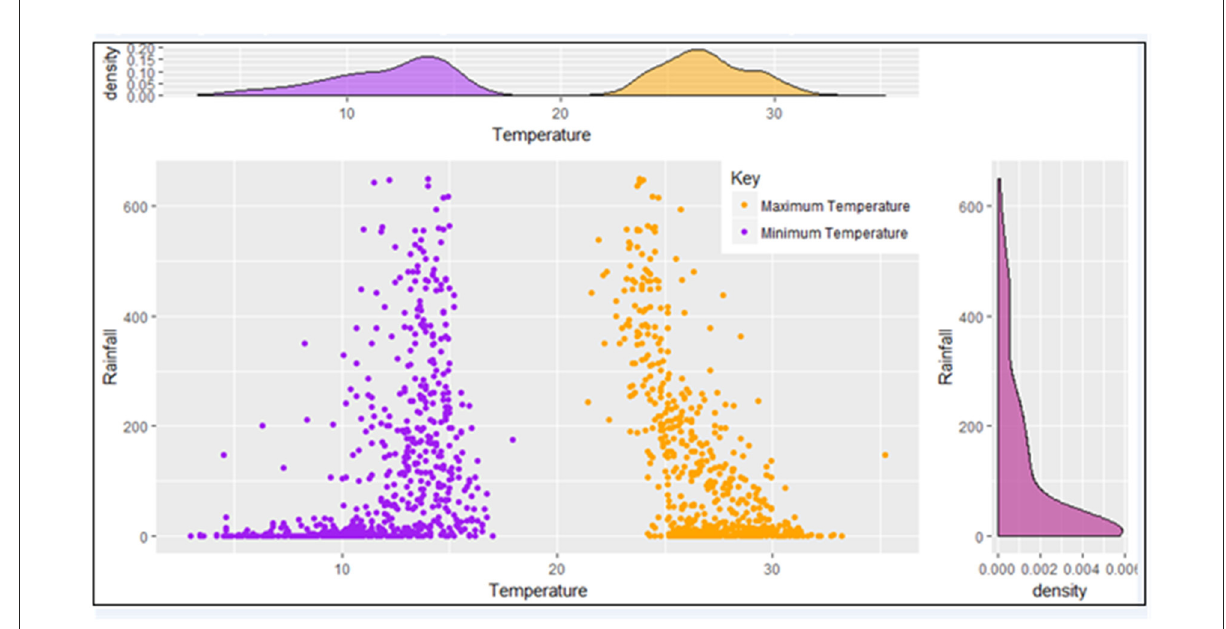
FIGURE4 Marginal and joint distribution of average rainfall with minimum and maximum temperature from 1961 to 2015.